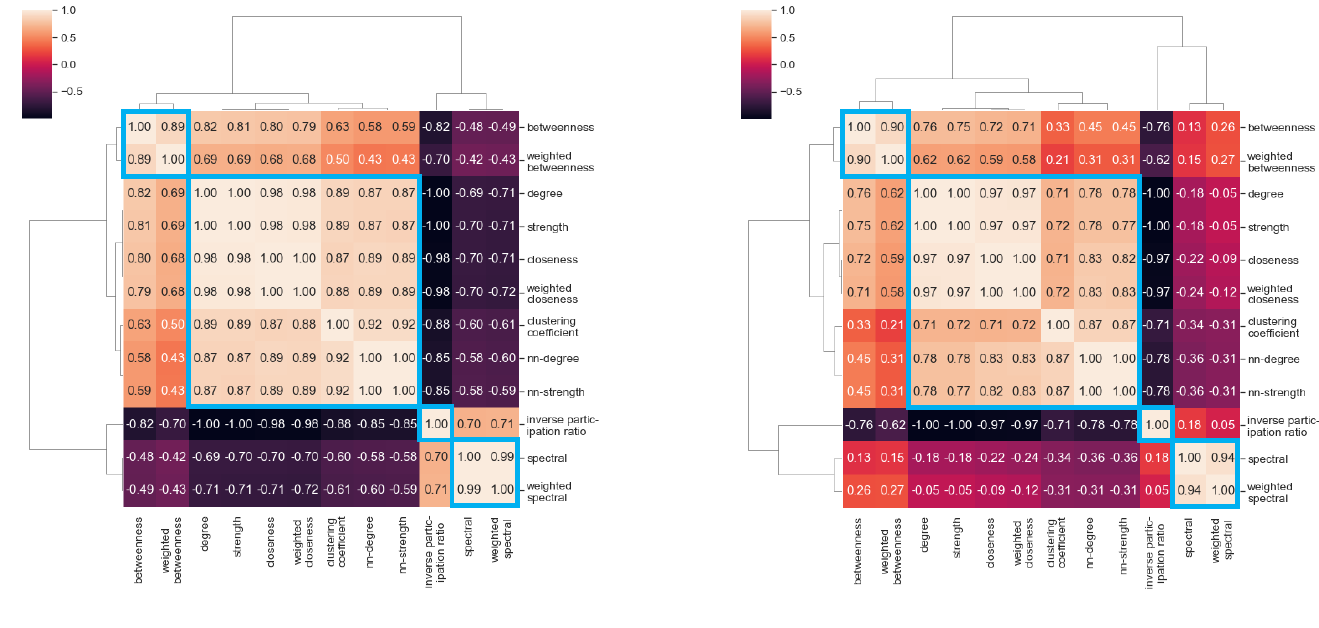
( a ) Control group TD. Figure 3. Spearman correlation-based cluster maps of the centrality